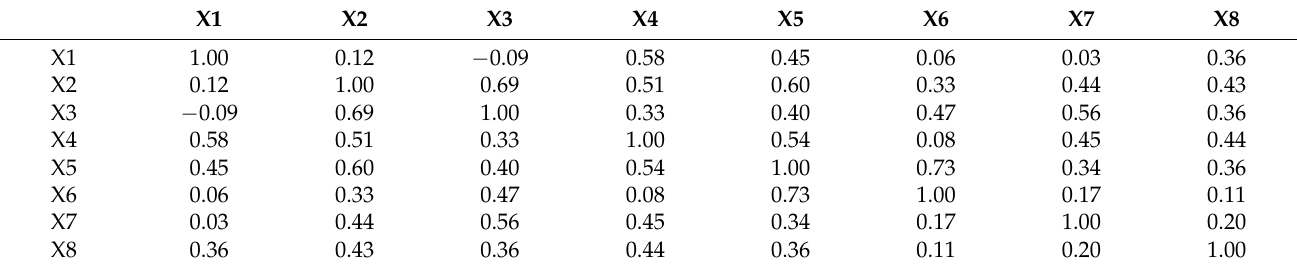
Table 4. Pearson correlation matrix for the indicators adopted for the